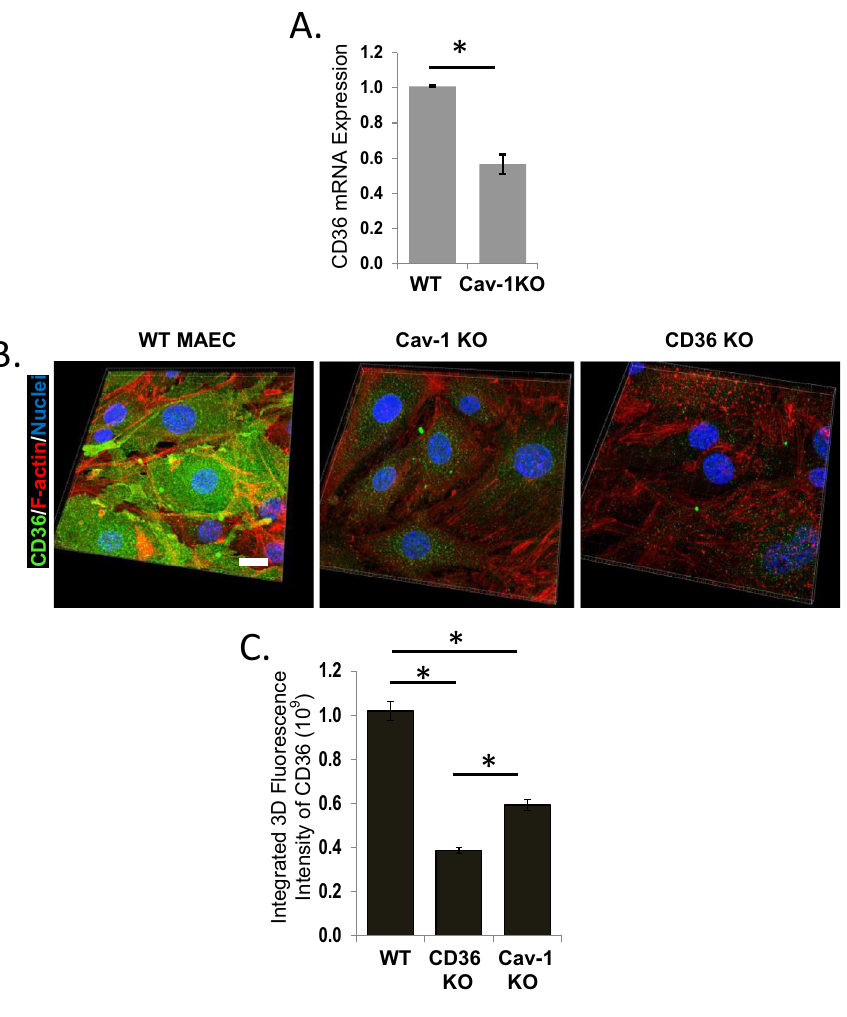
Figure 2. Cav1 regulates the expression of oxLDL scavenger receptor CD36. ( A ) Real-time PCR plot showing decreased CD36 mRNA expression in Cav-1 KO MAECs. ( B ) Representative 3D rendered confocal images showing CD36 expression in WT, CD36 KO and Cav-1 KO MAECs and ( C ) average integrated 3D fluorescence intensity of CD36 (n = 4, 5–8 cells per condition/experiment). Scale bars are 10 µm. *P < 0.05 by